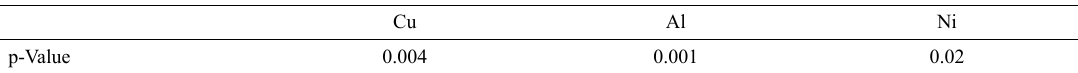
Table 6. Statistical comparison of the EDS results by a one-way ANOVA of the modified and quenched aluminum bronzes (Cu-Al-Ni SMA).